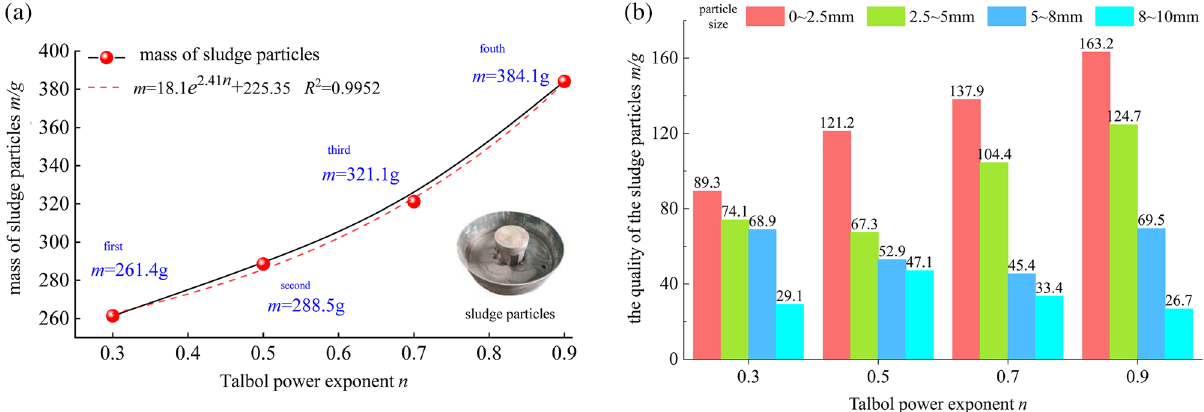
Figure 8. Silt particles of the samples at the different levels.